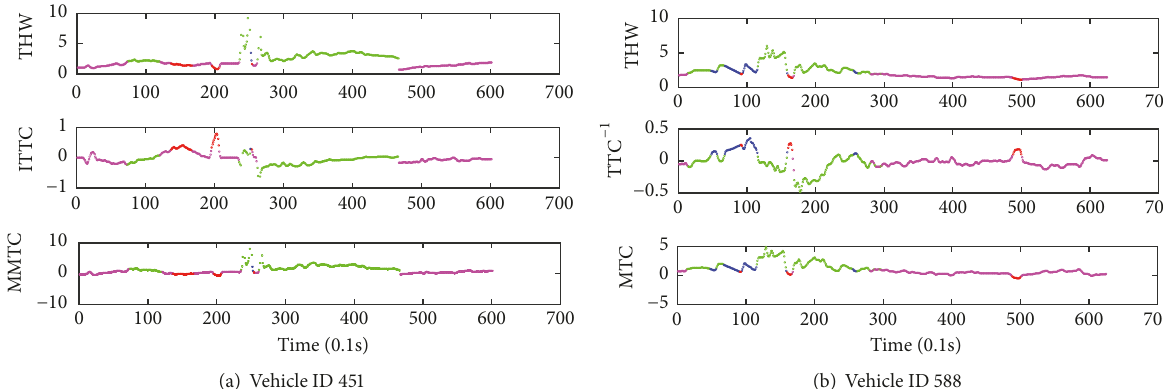
Figure 4: Trajectory segments for four drivers based on threshold values of ITTC and